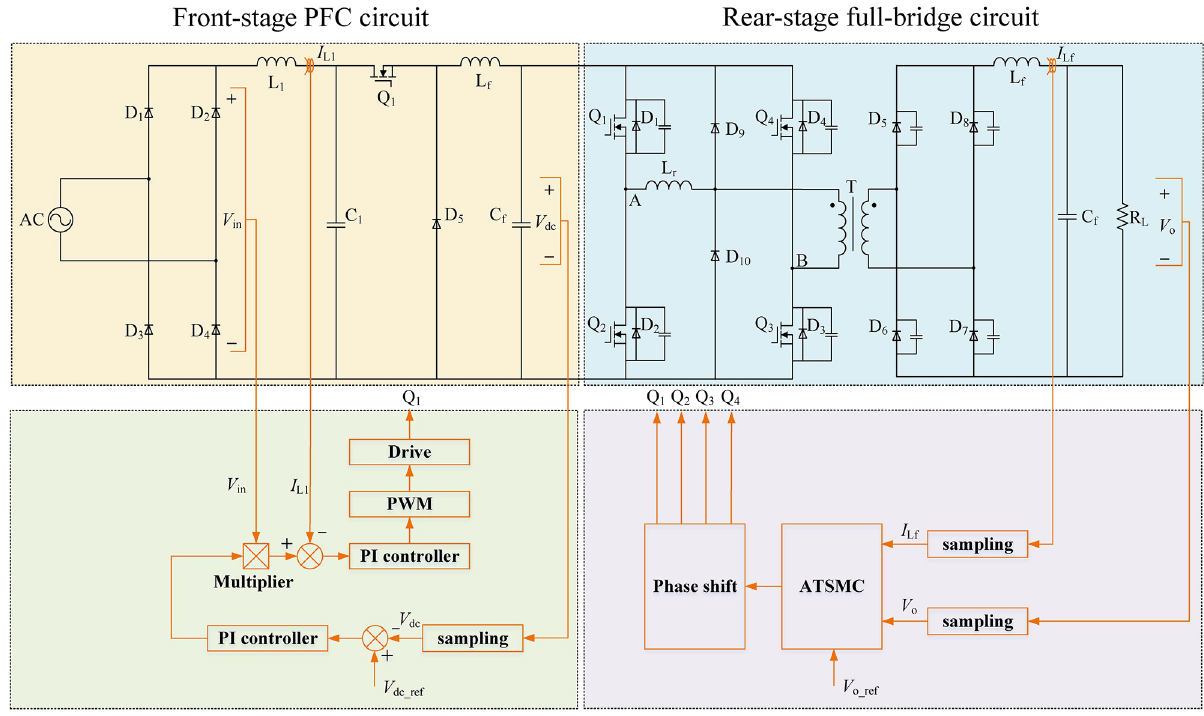
Fig 6. Control strategy of two-stage AC/DC